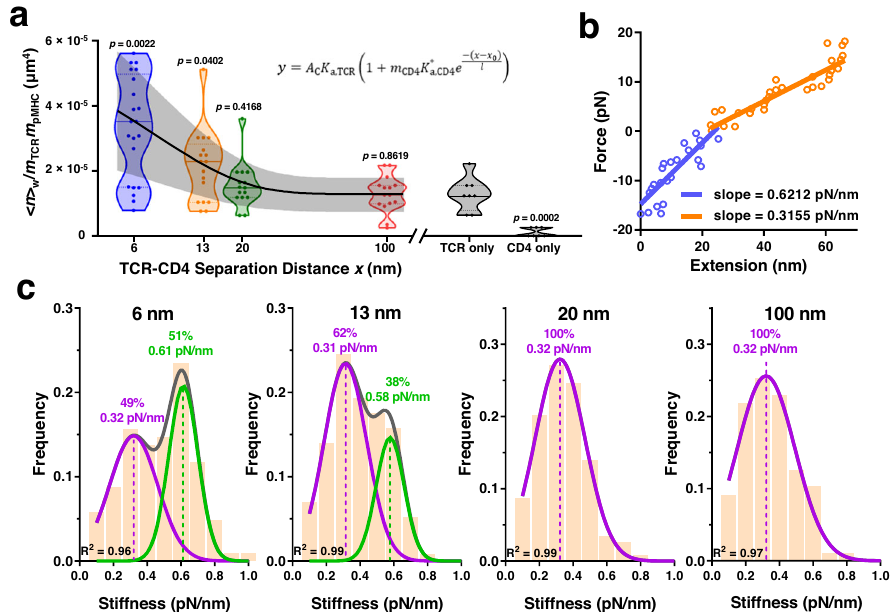
Fig. 5 | TCR-CD4 cooperativity is optimal at 7-nm spacing. a Normalized whole number of bonds < n > w / m TCR m pMHC for pMHC-bearing RBCs interacting with DNA origami beads presenting TCR-CD4 pairs at 6, 13, 20, or 100nm spacing, or pre- sentingTCRaloneorCD4along(points, n =21,17,15,15,8,and7cell-beadpairs).In the violin plots that show data densities, the solid lines in the middle represent mean and the lower and upper dotted lines represent the fi rst and third quartiles. Equation 4 was fi t (mean ± SE curves) to the < n > w / m TCR m pMHC vs separation dis- tance( x )datausingtheCD4density( m CD4 =31 μ m − 2 )measured by fl owcytometry. P -values indicate comparison with TCR only group using two-tailedMann-Whitney